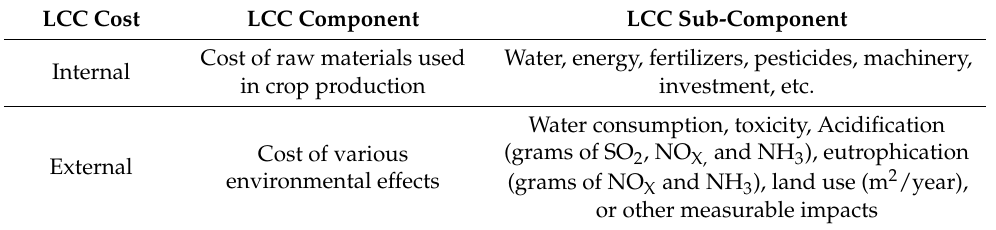
Table 1. Classification of life cycle cost components.